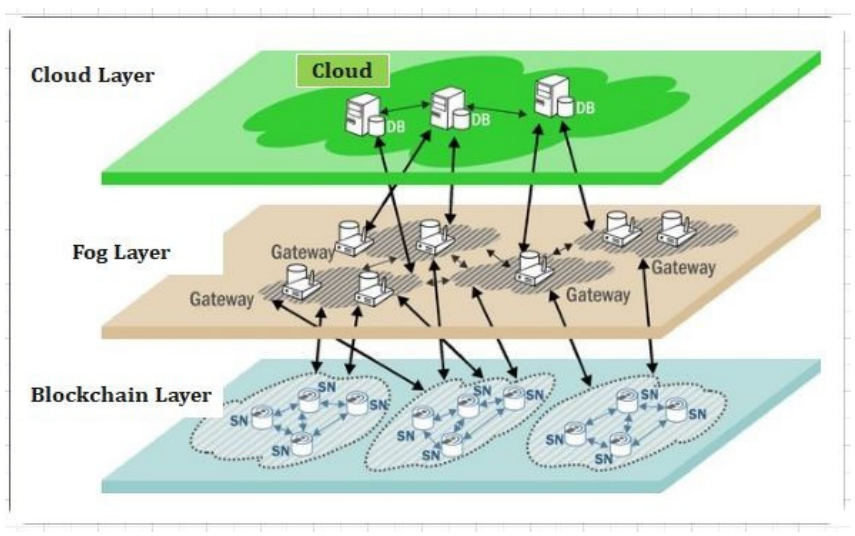
Figure 6. Proposed secure searchable encryption system using a DL-based intrusion detection system.